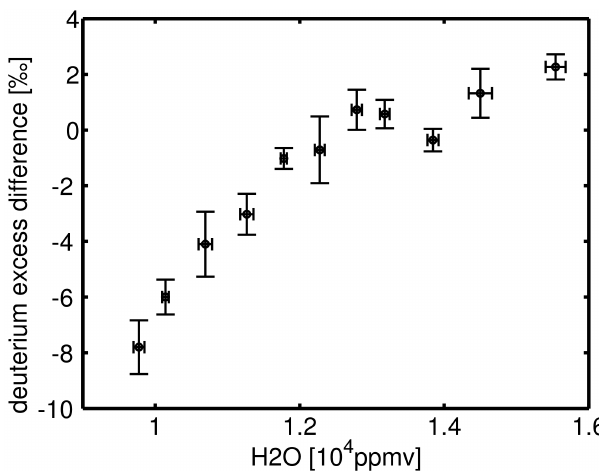
Fig. 14. Dependency of the deuterium excess difference between L1115-i and WVIA on the ambient water vapour mixing ratio dur- ing the comparative field measurement on the roof of a tower build- ing in Zurich from 19–26 July